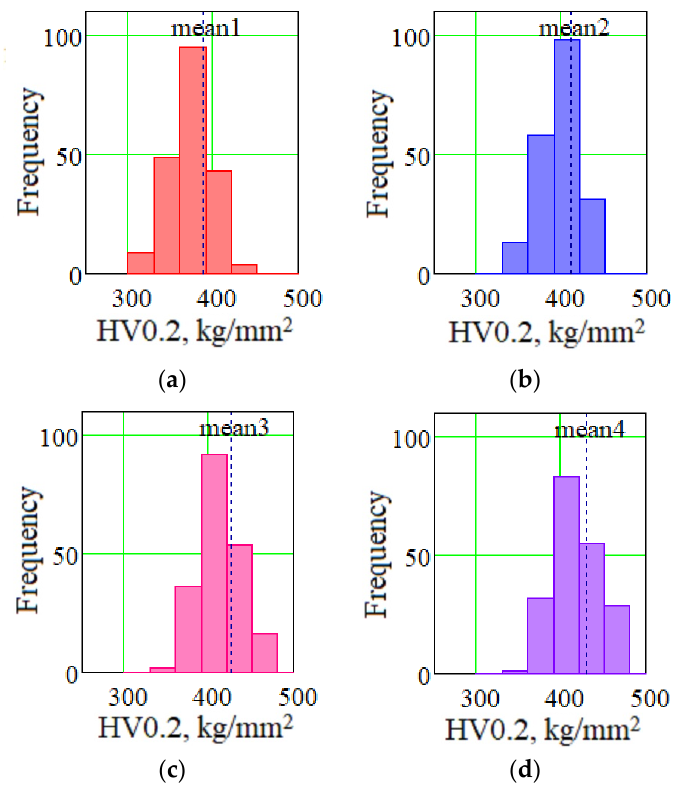
Figure 18. Block diagrams of frequency distributions of microhardness values HV 0.2 kg/mm 2 : ( a ) CMT deposition; ( b ) CMT deposition with forging; ( c ) CMT deposition with heat treatment; ( d ) CMT deposition with forging and heat treatment. Table 2. Microhardness of specimens obtained using different options, HV 0.2 kg/mm 2 .